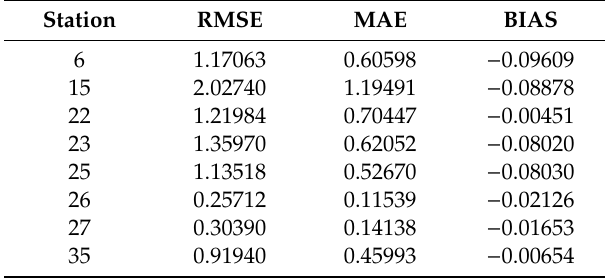
Table 5. RMSE, MAE and bias values in each station for MLPNN models (RMSE: root mean squared error, MAE: mean absolute error, BIAS: bias or historial average error, MLPNN: multilayer perceptron neural